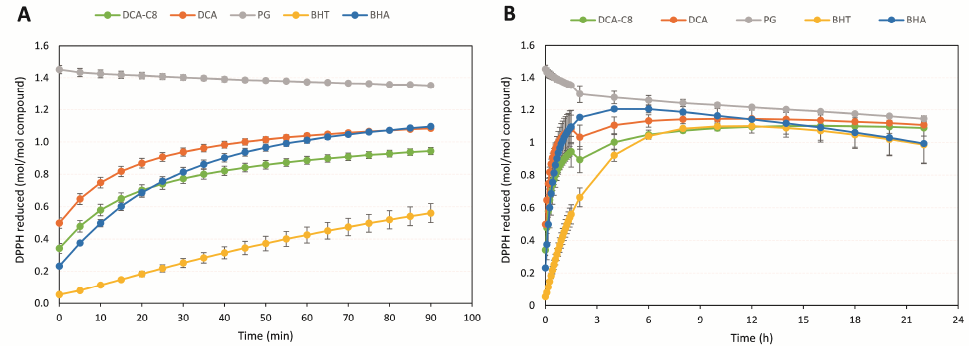
Figure 3. Time-course of DPPH scavenging ( A ) during short-term (90 min) and ( B ) long-term (22 h) incubation. Values are the average of two independent measurements ± standard deviation.